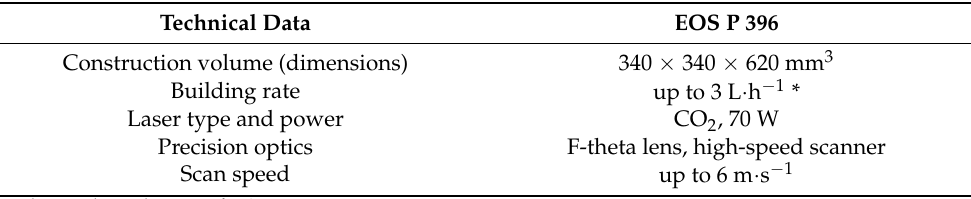
Table 2. Technical data of 3D printers [57,58].